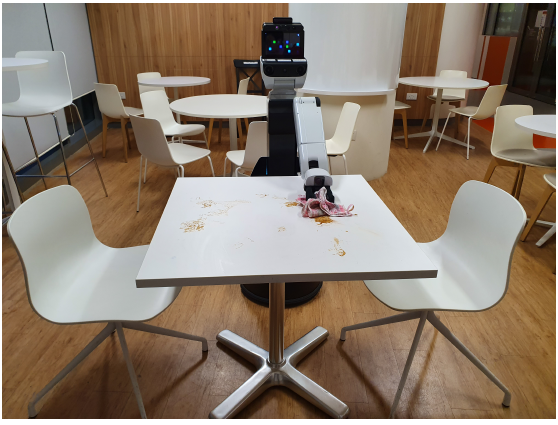
Figure 6. Experimental test